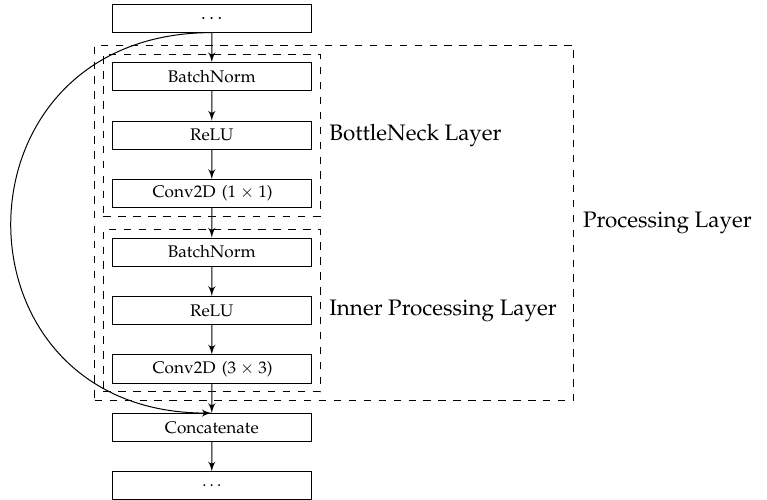
Figure 2. A Processing Layer in the SODBAE skeleton architecture (consisting of an initial BottleNeck Layer, followed by component batch normalisation, ReLU, and convolutional layers making up an Inner Processing Layer).